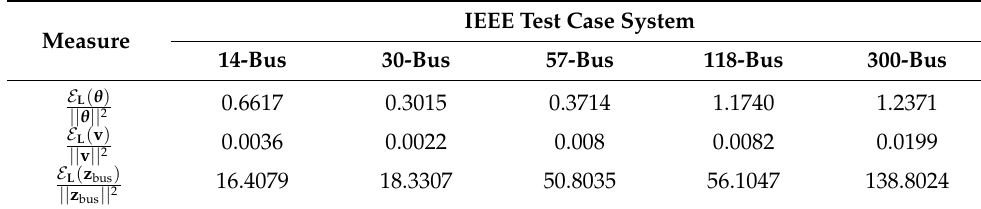
Table 1. Normalized smoothness values of IEEE